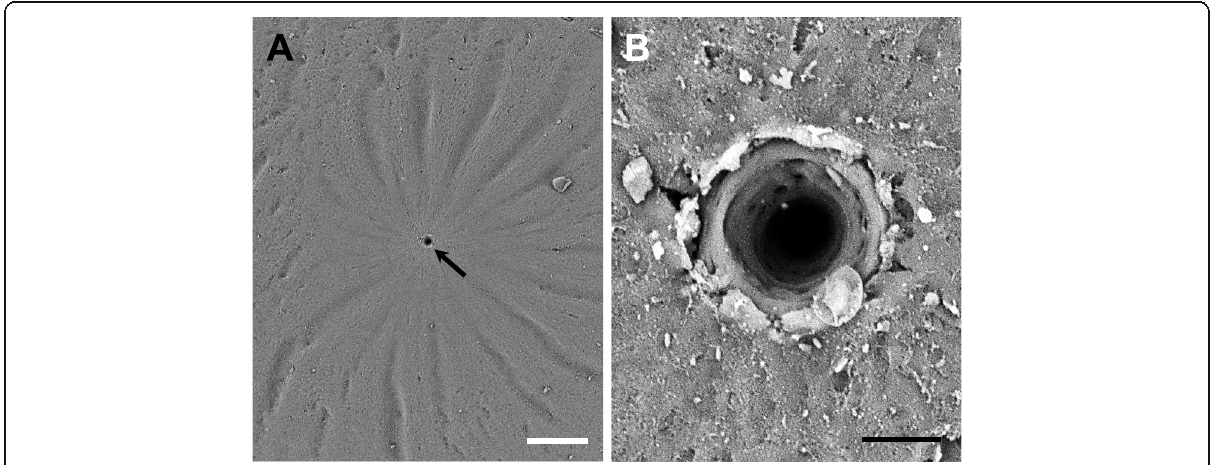
Fig. 2 Scanning electron micrographs of a micropyle on the area of the animal pole from fertilized egg of A. cirrhosus . The micropyle (arrow) was surrounded by 15 – 19 furrow lines of egg envelope in a spoke-like pattern ( a ). When magnified by scanning electron microscope, the micropyle was funnel shape ( b ) (Scale bar = A; 100 μ m, B; 10 μ